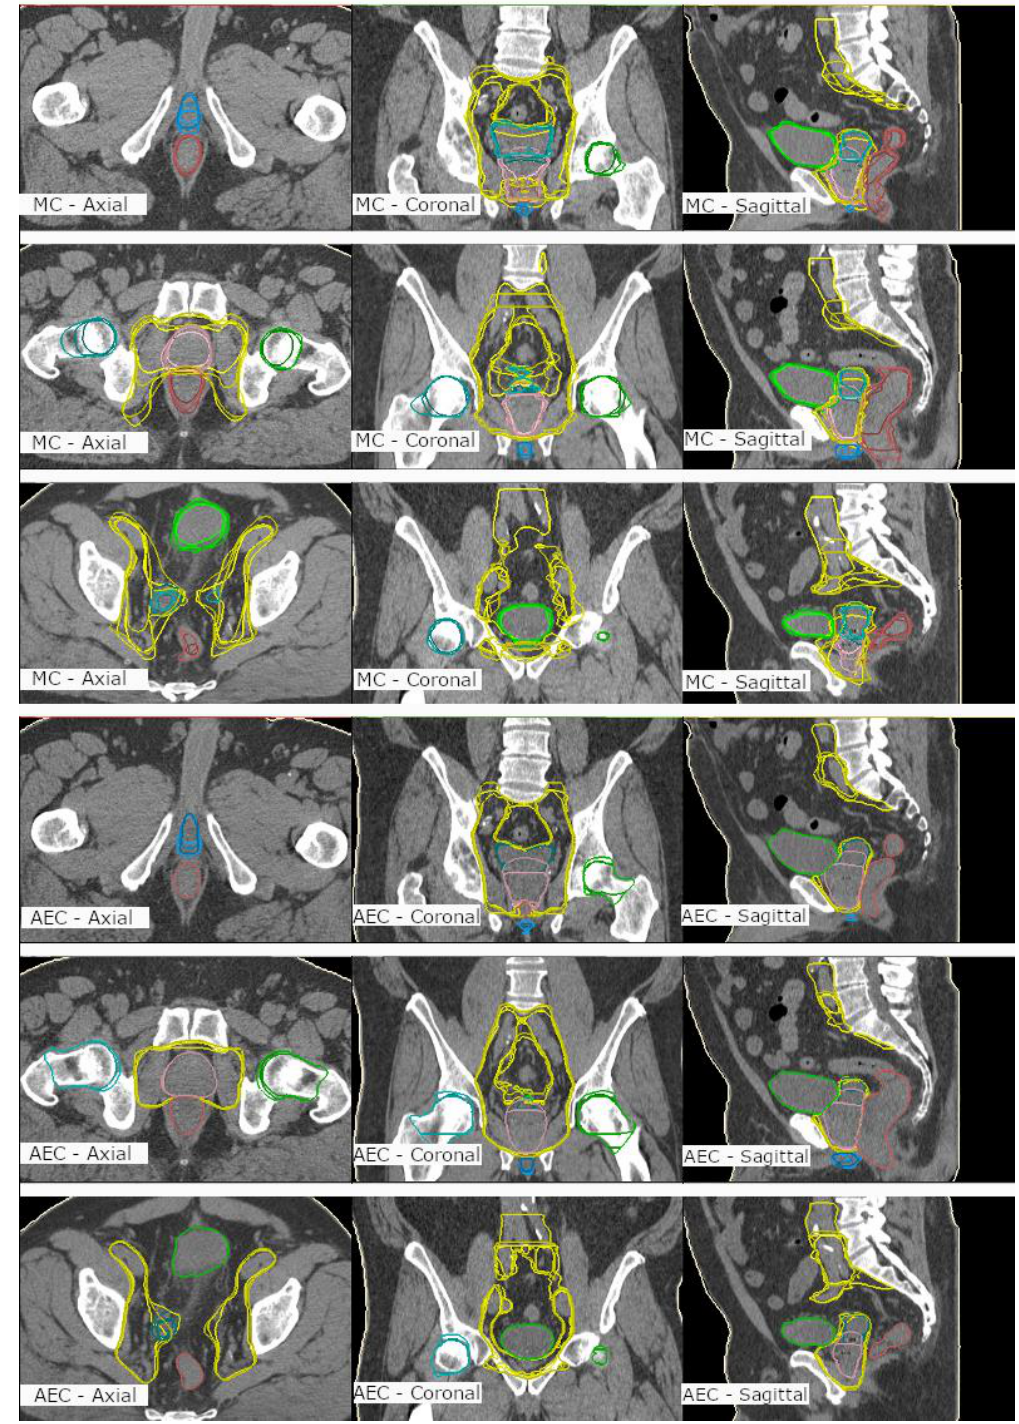
Figure 2. Manual contouring (MC) ( upper 9 images ) and automated and edited contouring (AEC) ( lower 9 images ) of prostate (pink), seminal vesicles (turquoise), lymph nodes (yellow), bladder (light green), rectum (brown), femoral heads (green&light turquoise) and penile bulb (blue) by four oncologists on one patient’s computed tomography scan. Left column: axial plane, middle column: coronal plane; right column: sagittal plane.